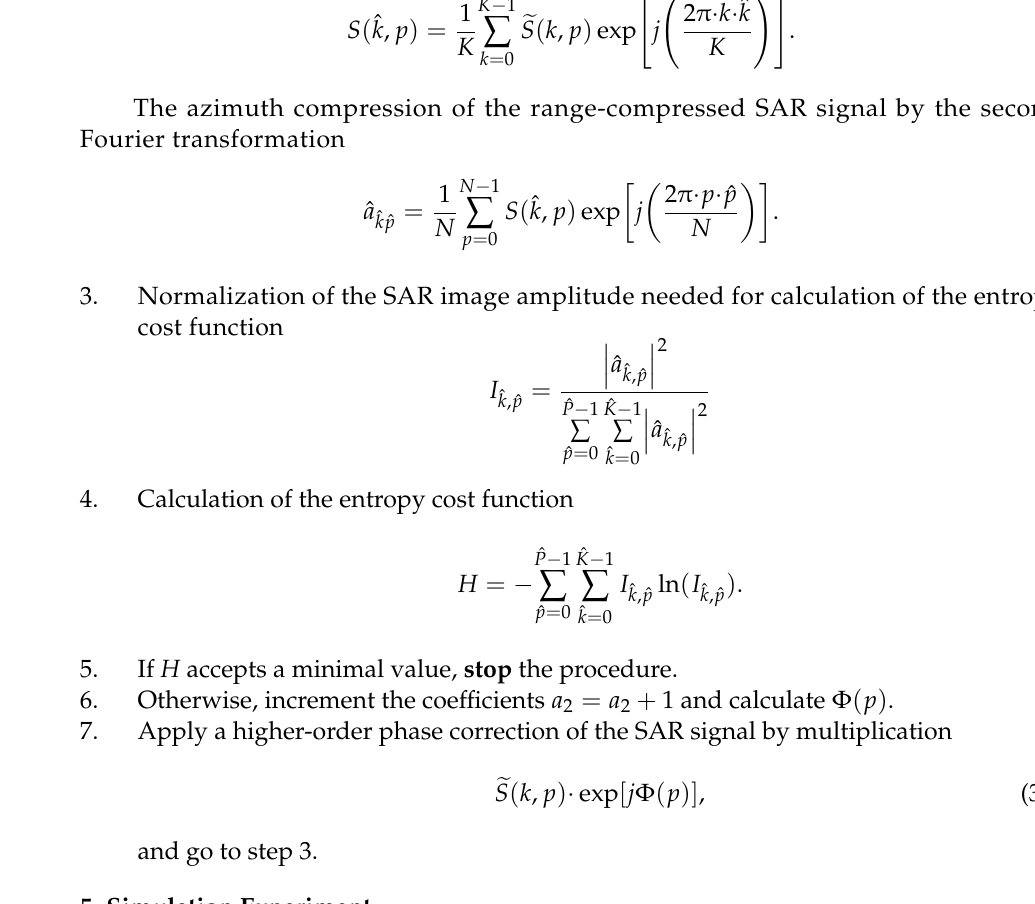
(Figure 2). The numbers of the reference points on the axes O (cid:48) X , O (cid:48) Y and O (cid:48) Z are as follows: I = 100, J = 100 and K = 10. The mathematical expectation of the normalized intensities of the scattering points placed on the ship target is a ijk =